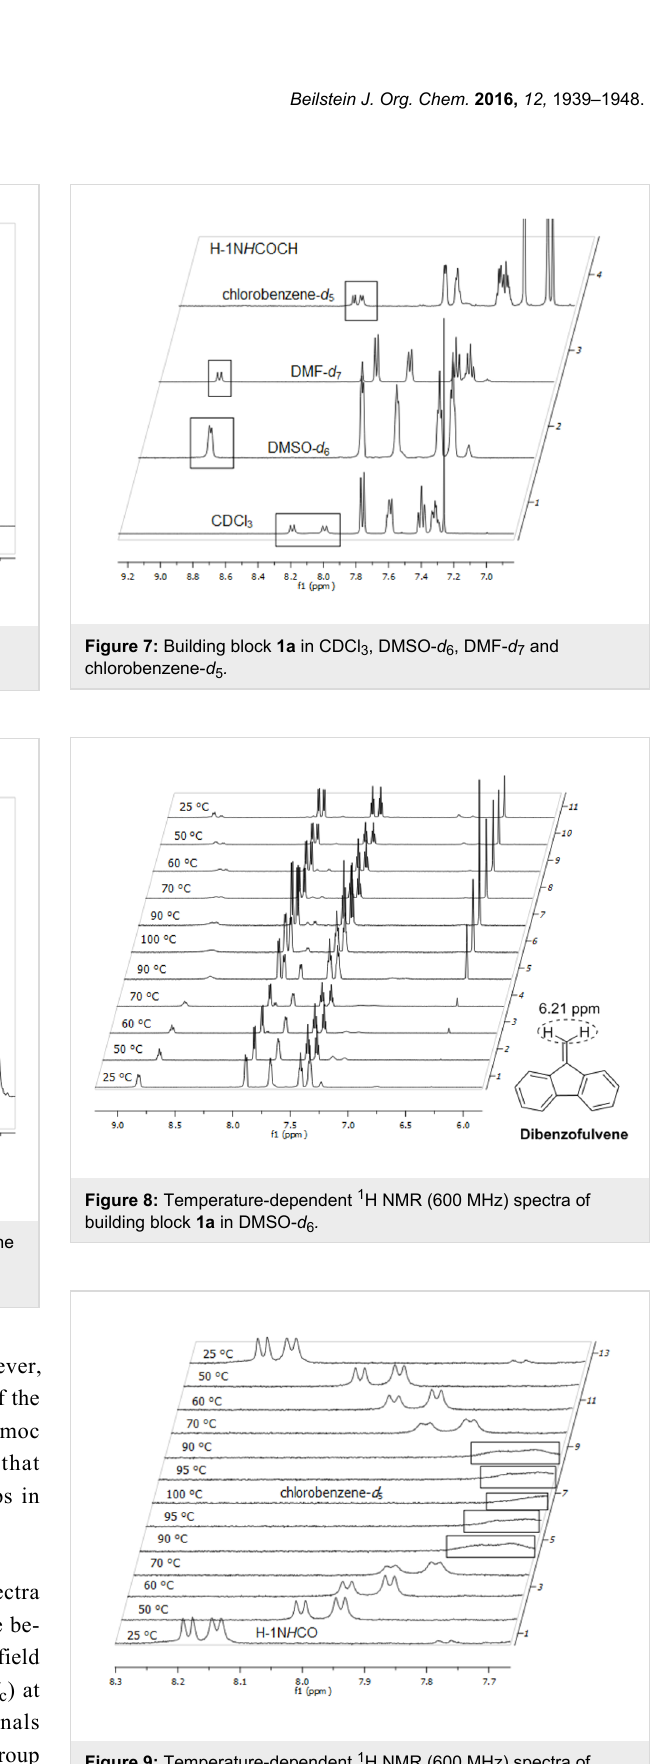
Figure 9: Temperature-dependent 1 H NMR (600 MHz) spectra of building block 1a in chlorobenzene- d 5 , broadened signals near the co- alescence temperature are